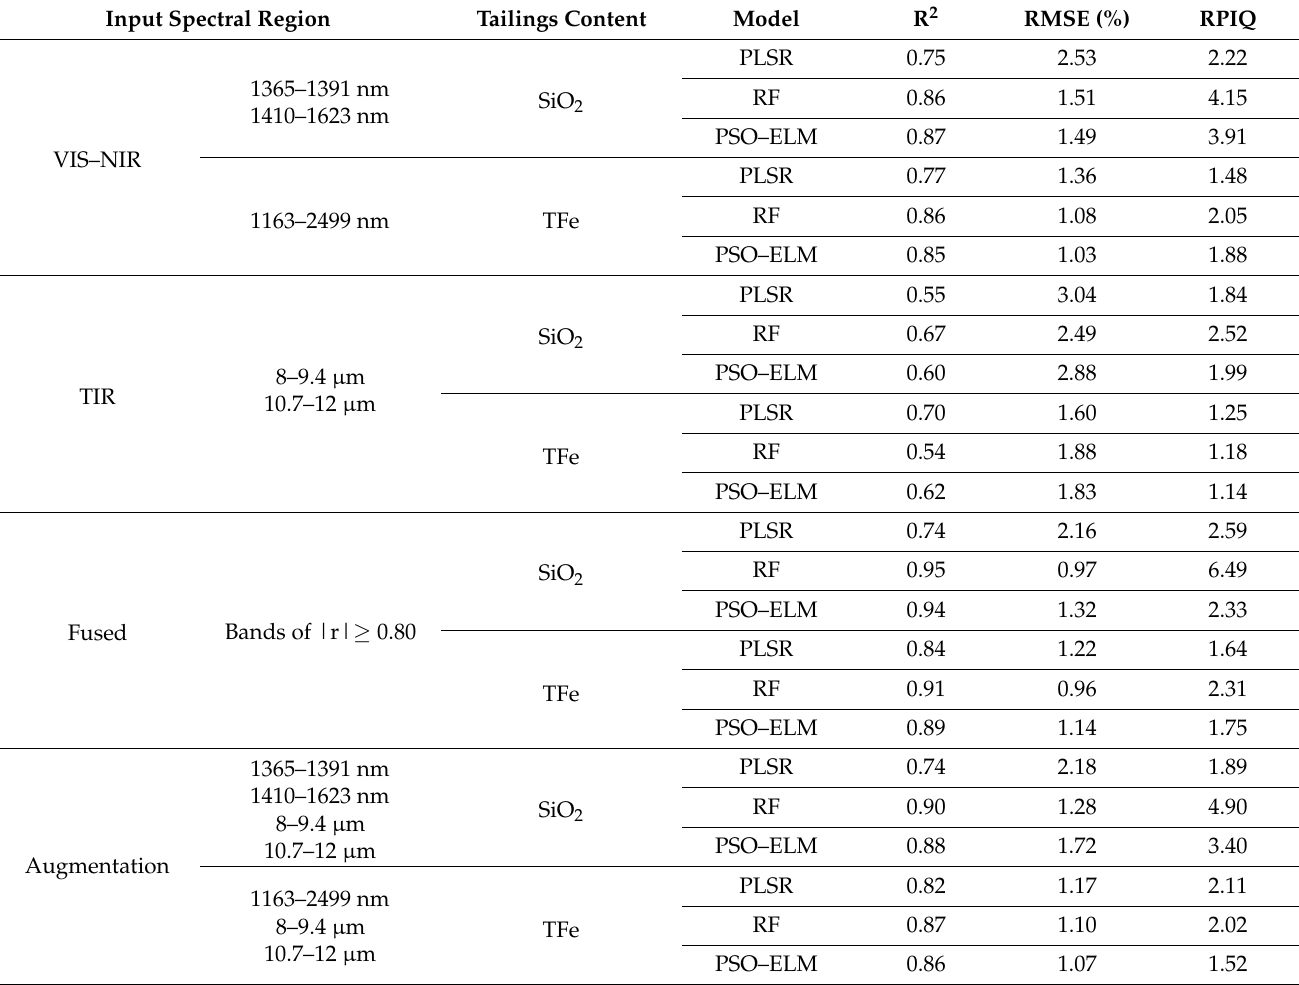
Table 1. Model accuracies of TFe and SiO 2 in individual (VIS–NIR and TIR), data augmentation, and OPA-fused spectral